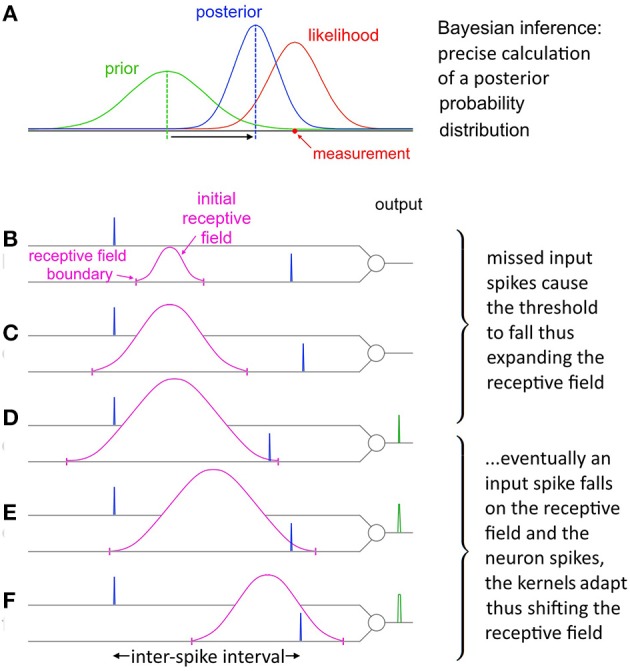
Evolution of SKAN's receptive field in response to input. (A) Total resultant change in SKAN's receptive field after multiple pattern presentations. (B) SKAN with a small initial receptive field which does not match the ISI distribution. The input spike lands outside the receptive field boundaries. (C) As more ISI's fall outside the small receptive field the threshold falls and the receptive field expands, but without shifting the position of its maximum value. (D) An ISI just falls on to the greatly expanded receptive field producing an output spike. (E) The output spike causes the SKAN kernels to adapt shifting the receptive field toward the true position of the underlying process. (F) As more and more ISI's fall closer to the receptive field maximum wider output pulses are produced which adapt the kernels faster shifting the receptive field more rapidly while the resultant rise in the threshold contracts the receptive field. With enough observations the receptive field would eventually become centered on the input ISI distribution with the receptive field boundaries tracking the ISI's distribution.